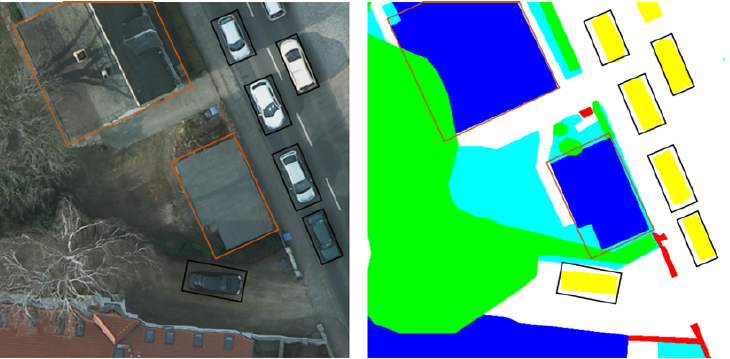
Figure 1. The challenge of urban remote sensing image